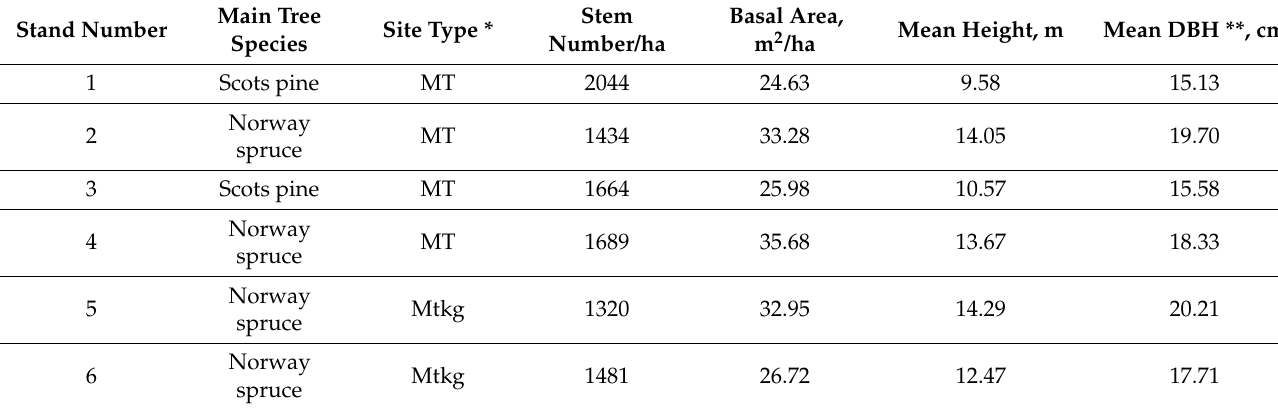
Table 1. Stand characteristics of stands